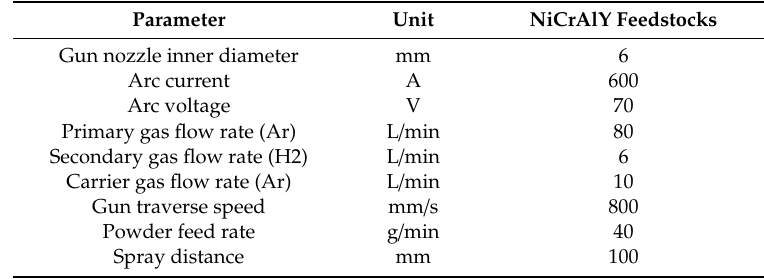
Table 2. Air plasma spray processing parameters.